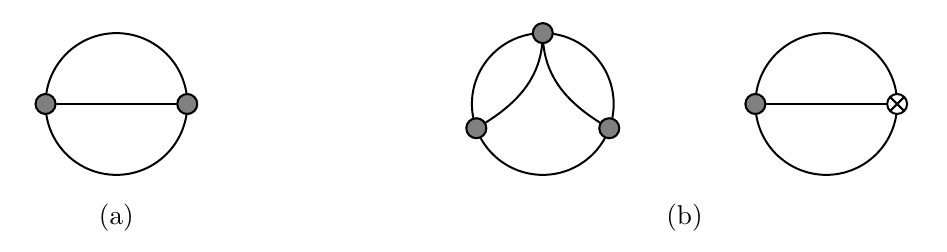
Figure 2 . Diagrams in coordinate representation for the corrections to the kinetic operator: (a) The k > 2 case receives the leading order contributions at two loops of order g 2 ; (b) the k = 2 case gets leading order contributions at three loops of order g 3